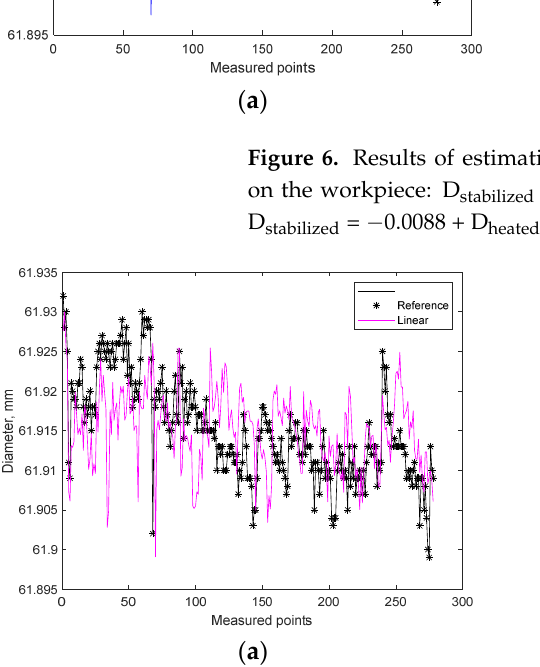
Figure 6. Results of estimation with the use of a model with bias: ( a ) measurement at point A on the workpiece: D stabilized = − 0.0086 + D heated ; ( b ) measurement at point B on the workpiece: D stabilized = − 0.0088 + D heated .